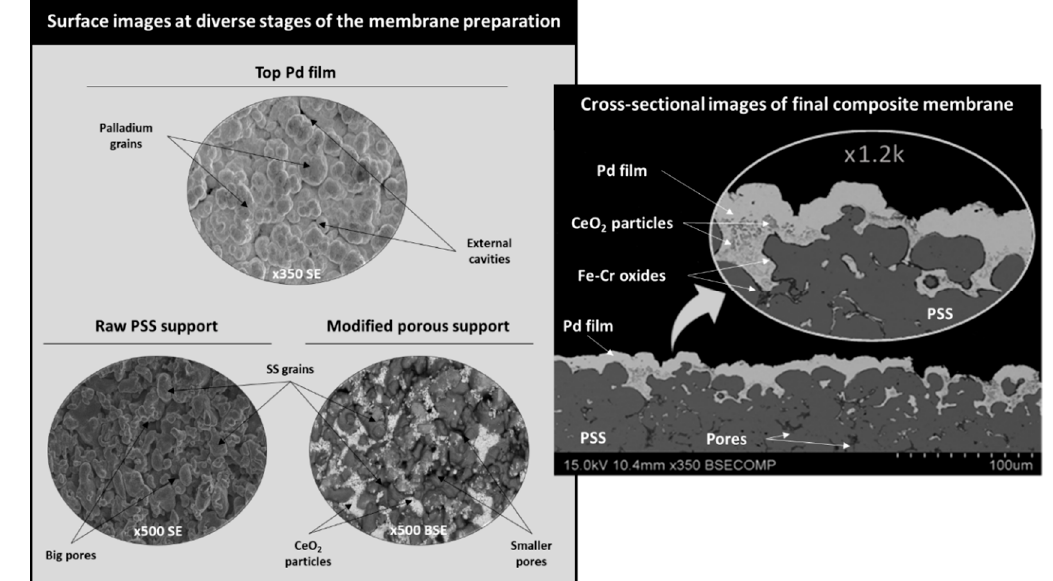
Figure 3. Morphology of the considered composite Pd-membrane for modeling: surface and cross-sectional SEM images at diverse stages of the membrane fabrication. BSE: back-scattering electrons, SE: secondary electrons, SS: stainless steel.